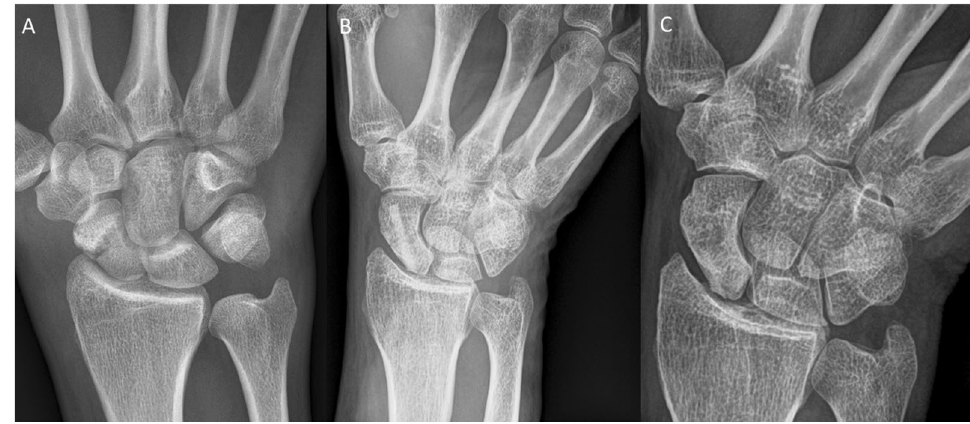
Fig. 4 Pseudarthrosis of the scaphoid in the middle third. A Pre-surgery. B 14 days post-surgery. C 27 months